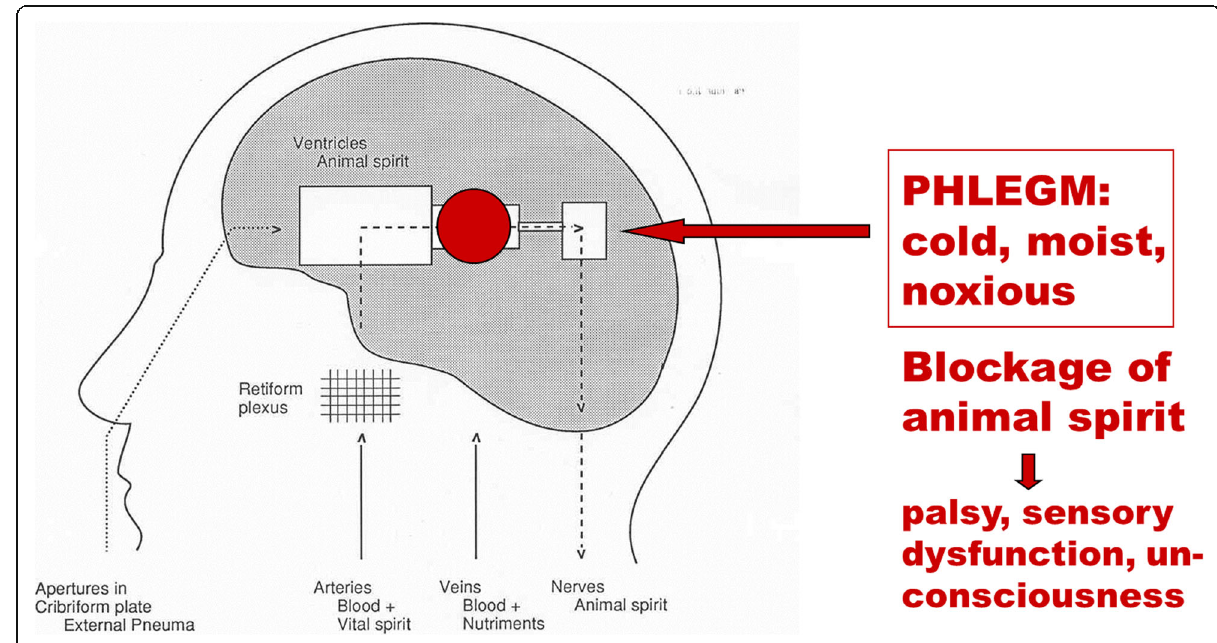
Fig. 3 Galen ’ s doctrine of apoplexy. Drawing by the